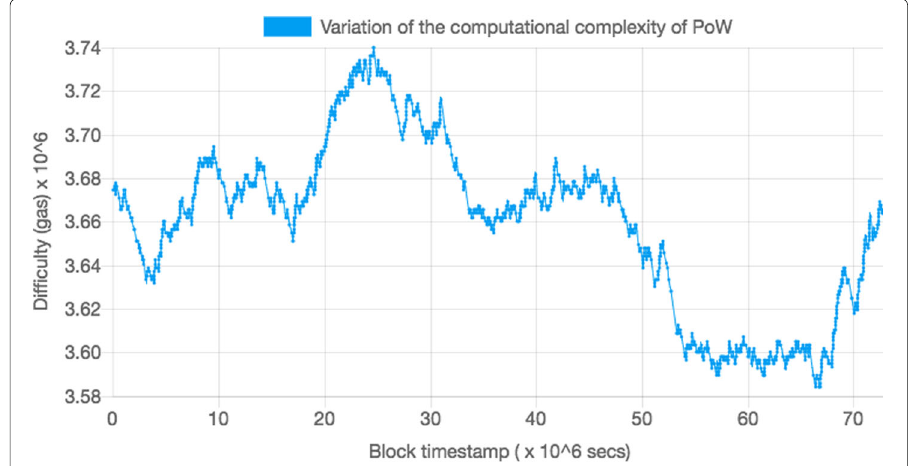
Fig. 7 PoW computational complexity over time on BOLL. This figure shows the growth of the Proof-of-Work (PoW) over time as more blocks get added to the blockchain. We note that the PoW time complexity does not usually grow, but in some cases reduces depending on the availability of computational resources